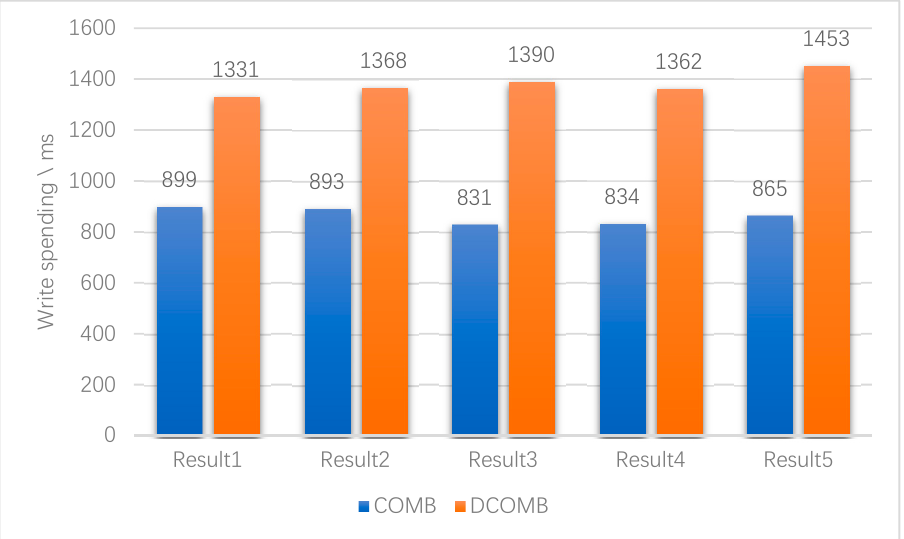
Figure 10. Time-consuming to insert data.